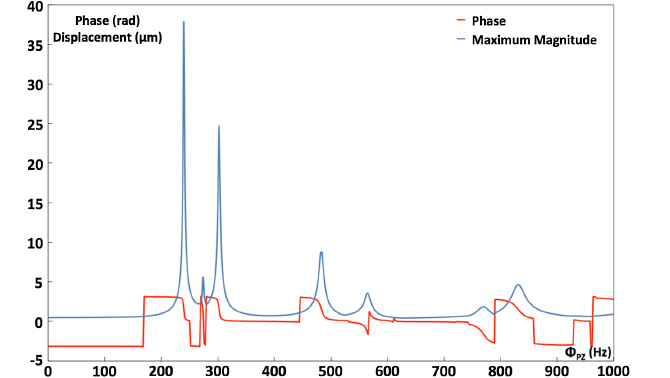
FIG. 11. Maximum displacement magnitude (blue) and the corresponding phase of the load (red) as a function of the piezoactuator frequency.